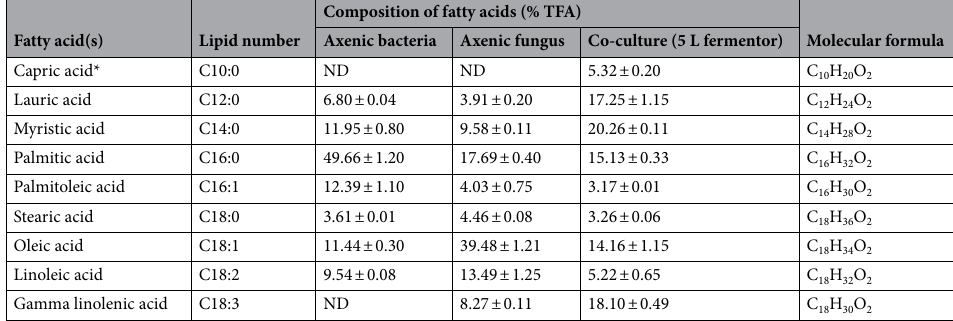
Table 3. Fatty acids profiles through Mucor plumbeus and Bacillus subtilis cocultures. “ND”: not detected. *New peak was induced during co-cultivation.